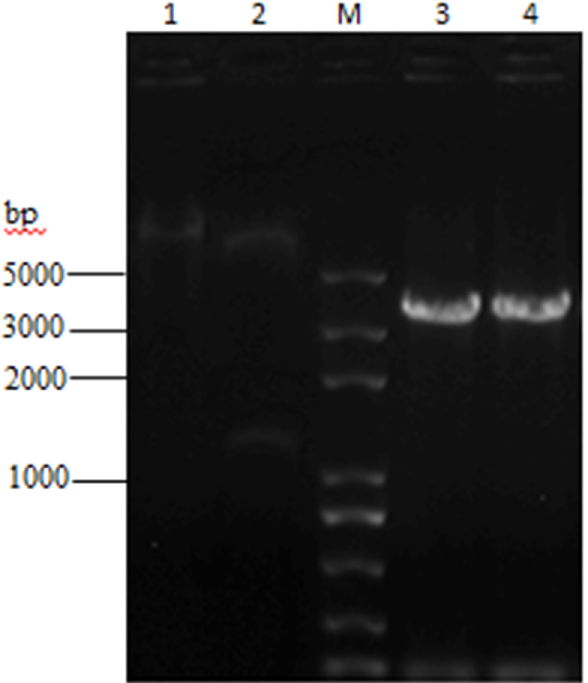
Fig 1. Agarose gel electrophoresis analysis of 3 combinant expression plasmid. The plasmid was confirmed by PCR and double digestion using NcoI and XhoI. Lane 1 was the fragment of recombinant plasmid DNA pTriEx-1.1 Hygro- β 2 -AR. Lane 2 was the electrophoresis results of digested products containing 2 fragments (6951 bp and 1257 bp). A 3300 bp fragment (lane 3 and lane 4) was amplified by PCR from the recombinant plasmid, which was identical with the sum of the size of target gene and vector sequences between NcoI and